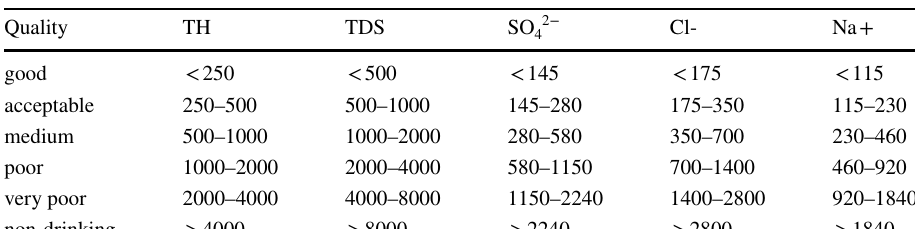
Table 4 Operating weight, relative weight, and the proposed measure concentrations for each parameter of groundwater